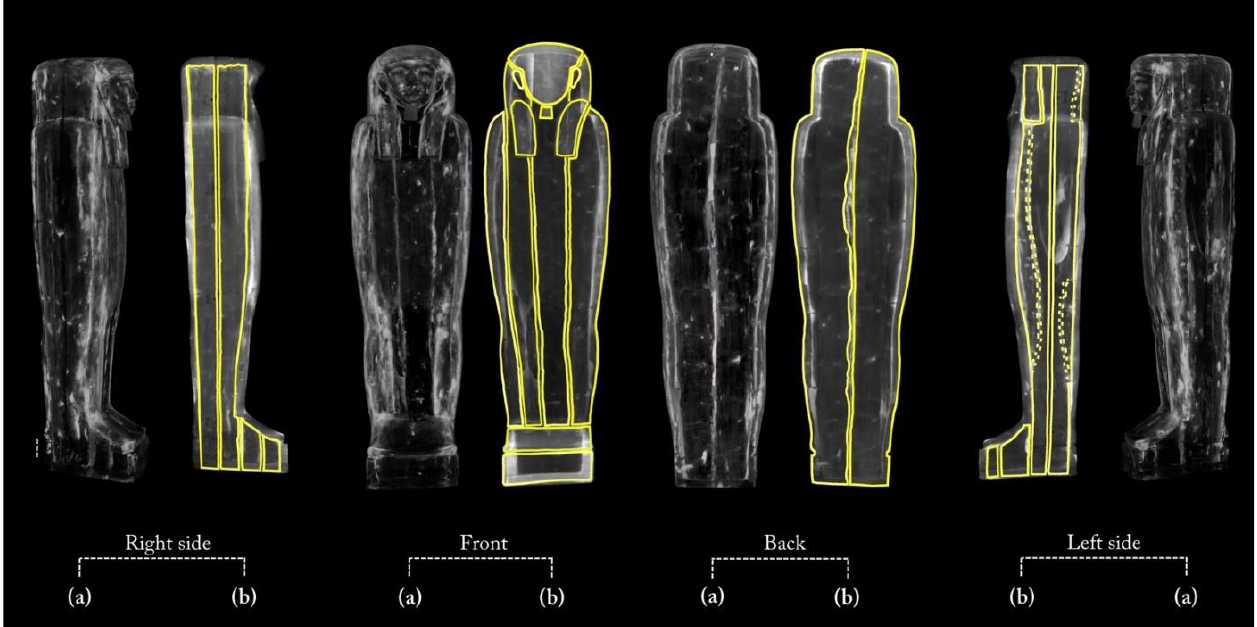
Figure 4. The results of the 14 C dating: in blue, the calibration curves (plus and minus one standard deviation); in red, the radiocarbon date; and in grey, the calibrated date.